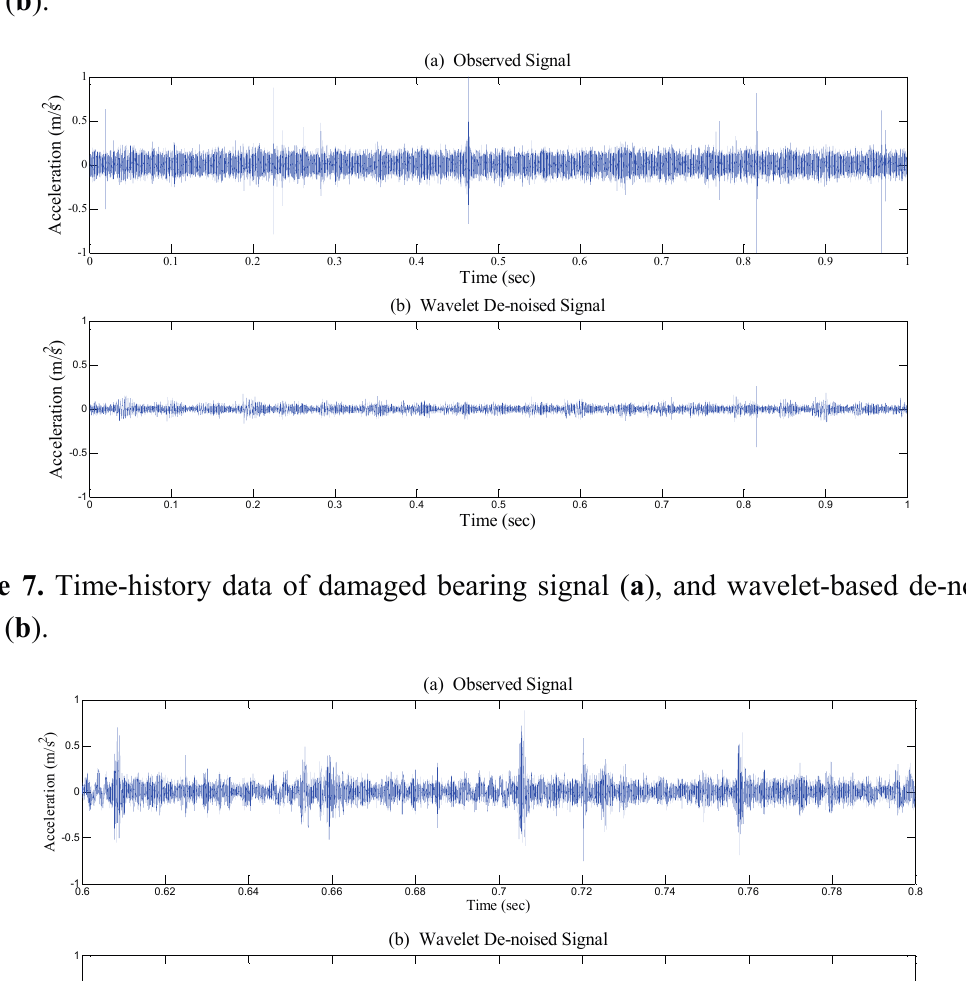
Figure 6. Time-history data of healthy bearing signal ( a ), and wavelet-based de-noised signal ( b ).